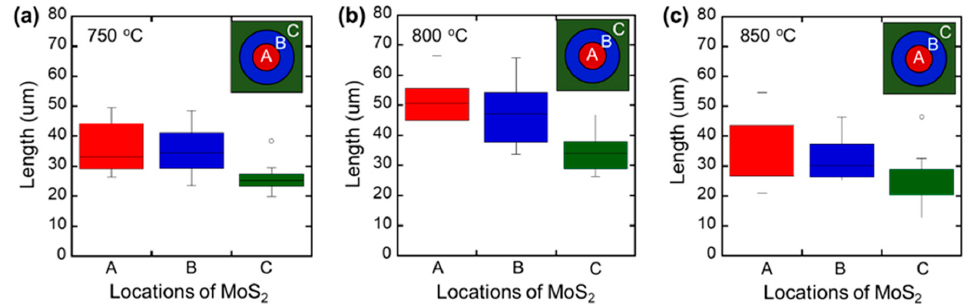
Figure 2. The statistical distribution of the lengths of one side of triangular MoS 2 crystals grown ( a ) 750 °C, ( b ) 800 °C, and ( c ) 850 °C, respectively. Three different regions, (A), (B), and (C), in each 1.5 cm 2 size substrate were measured. Region (A) refers to the 3 mm central circle, region (B) refers to another 5 mm circle outside of the region (A), and region (C) refers to the rest of the peripheral area to the edge of the sample.